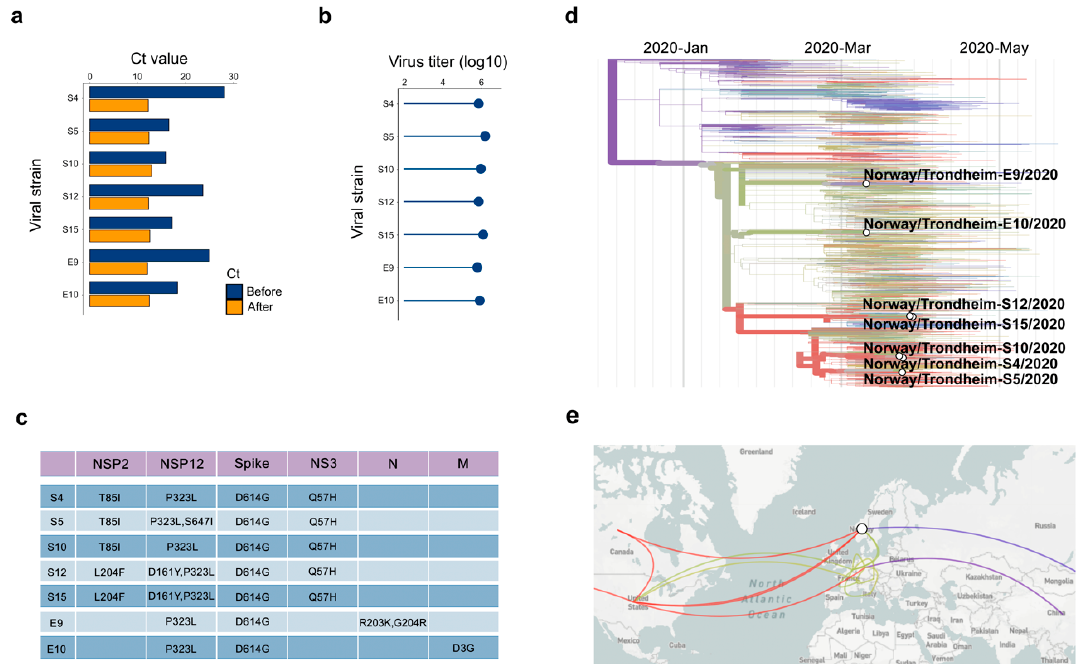
Figure 1. Isolation and characterization of 7 SARS-CoV-2 strains used in this study. ( a ) RT-qPCR analysis of 7 SARS-CoV-2 strains isolated from nasopharyngeal swabs. ( b ) Viruses amplified in Vero-E6 cells were quantified by plaque assay. ( c ) Table showing variations in amino acids between our SARS-CoV-2 strains and the reference hCoV-19/Wuhan/WIV04/2019 strain. ( d ) Phylogenetic analysis of 7 SARS-CoV-2 strains from Trondheim and other viral strains, which full-genome sequences were submitted to the GISAID database. ( e ) The origin of our 7 strains according to nextstrain.org.